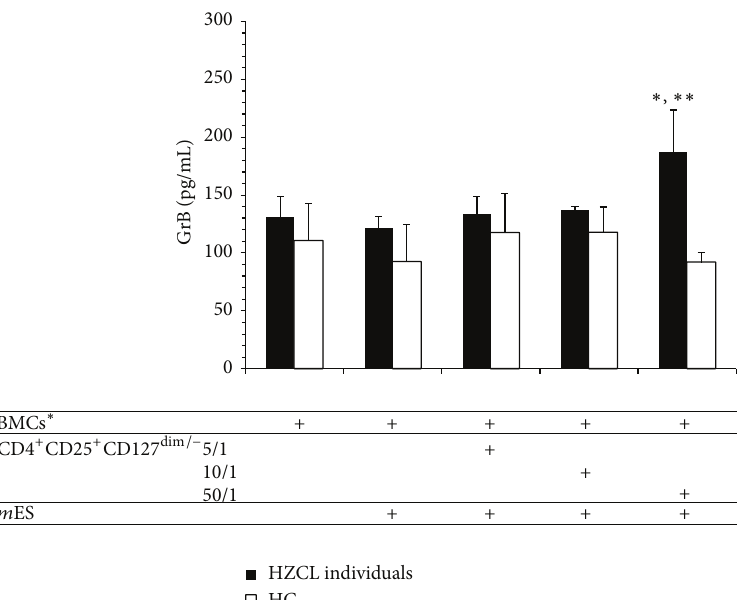
Figure 6: Lm ES induce GrB production by CD4 + CD25 + CD127 dim/ − regulatory T in HZCL. CD4 + CD25 + CD127 dim/ − regulatory T cells were purified from peripheral blood of 4 HZCL and 3 HC and stimulated with Lm ES (10 𝜇 g/mL) in vitro in the presence of mitomycin C-treated PBMCs (APCs) at different Effector/APC ratios for 5 days. Culture supernatants were used to determine GrB concentration. Results are expressed as the mean ± standard error of the mean of levels. Statistical analysis: ∗ 𝑃 < 0.05 when comparing HZCL to